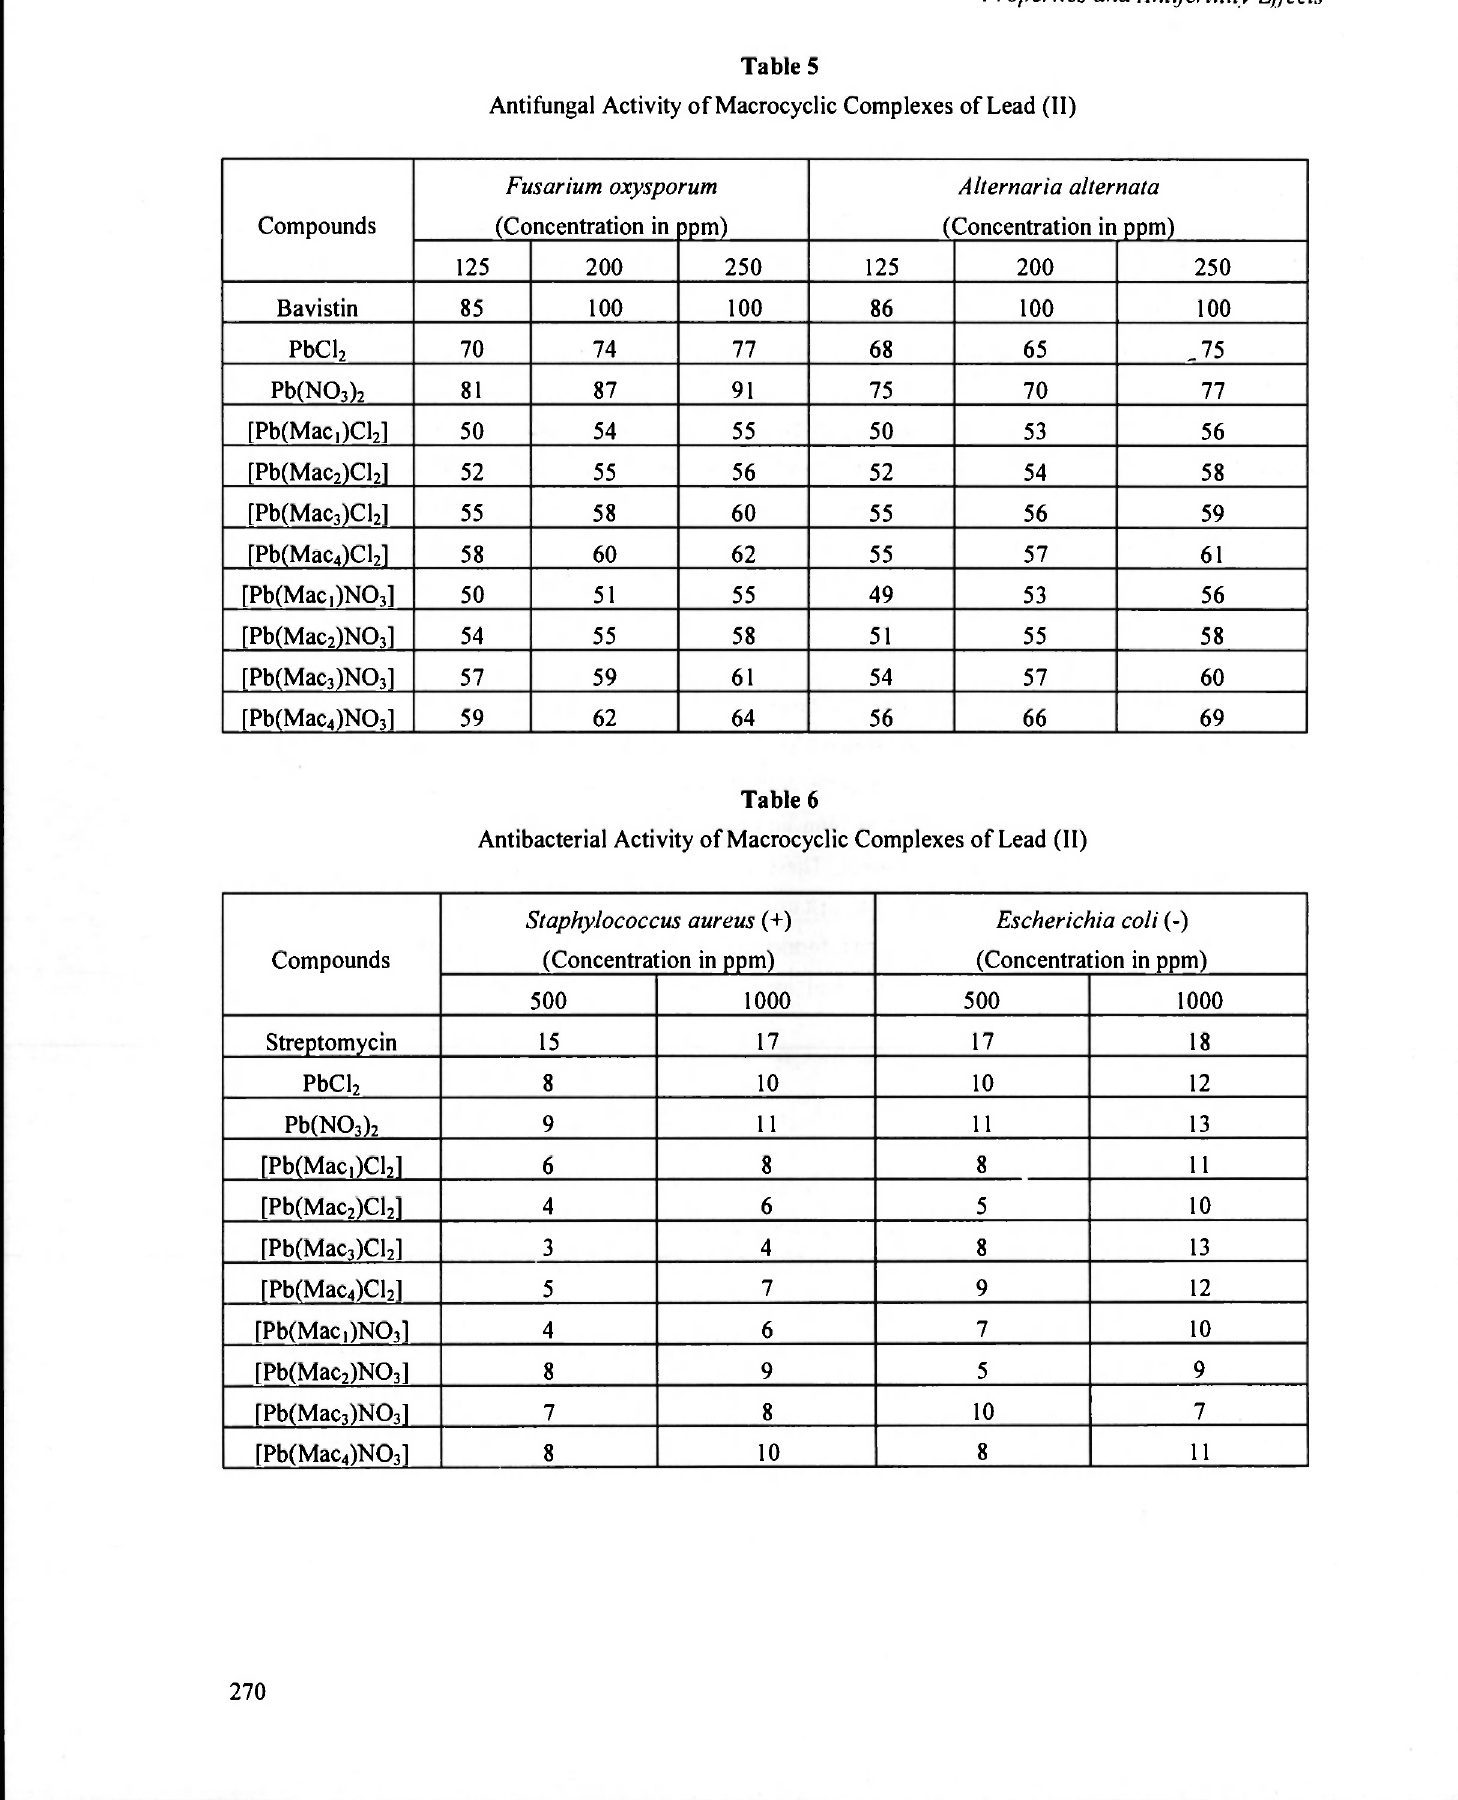
Antifungal Activity of Macrocyclic Complexes of Lead (II)